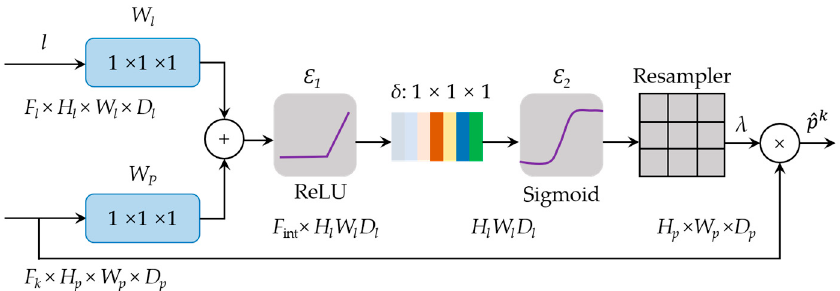
Figure 4. Illustration of the attention gate.